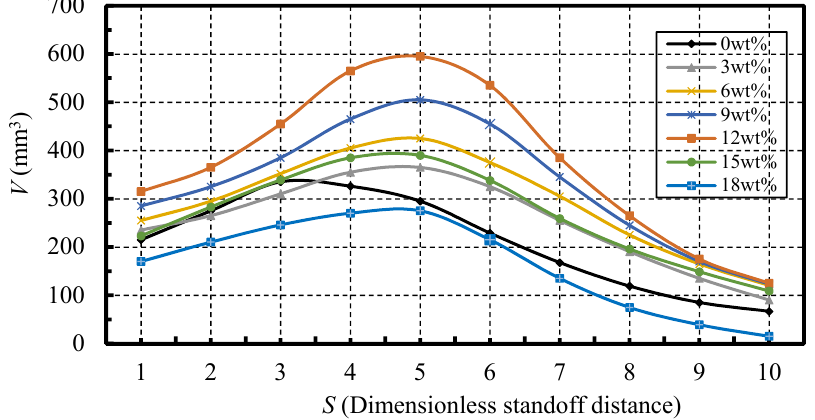
Figure 6. Effect of standoff distance on rock erosion capability of the SC-CO 2 jet.